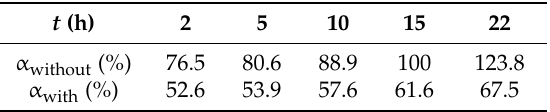
Table 6. Dependence of α on electroforming time.